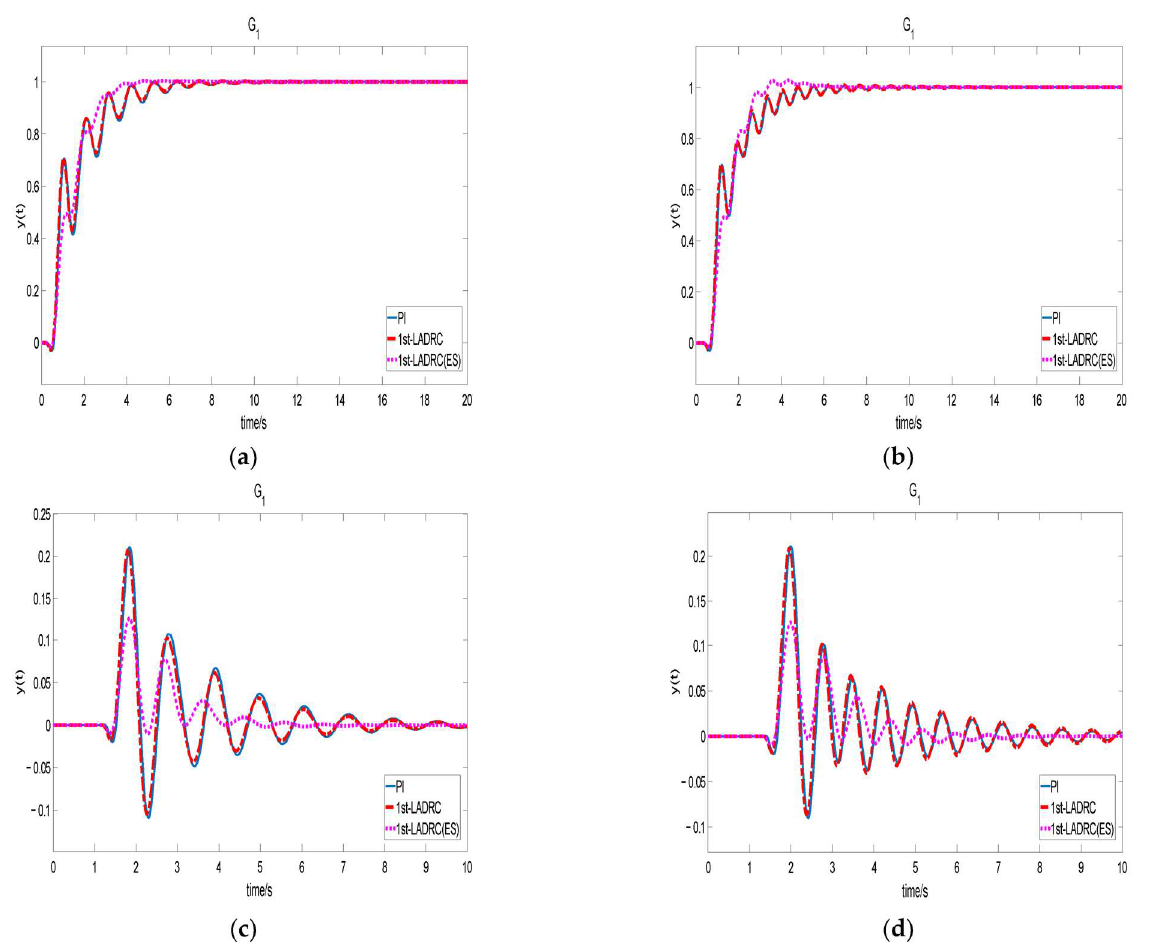
Figure 10. Response of G 1 under PI and LADRCs with different time delay. Step response curve when τ decreases by 30% ( a ) and increases by 30% ( b ). Disturbance response curve when τ decreases by 30% ( c ) and increases by 30% ( d